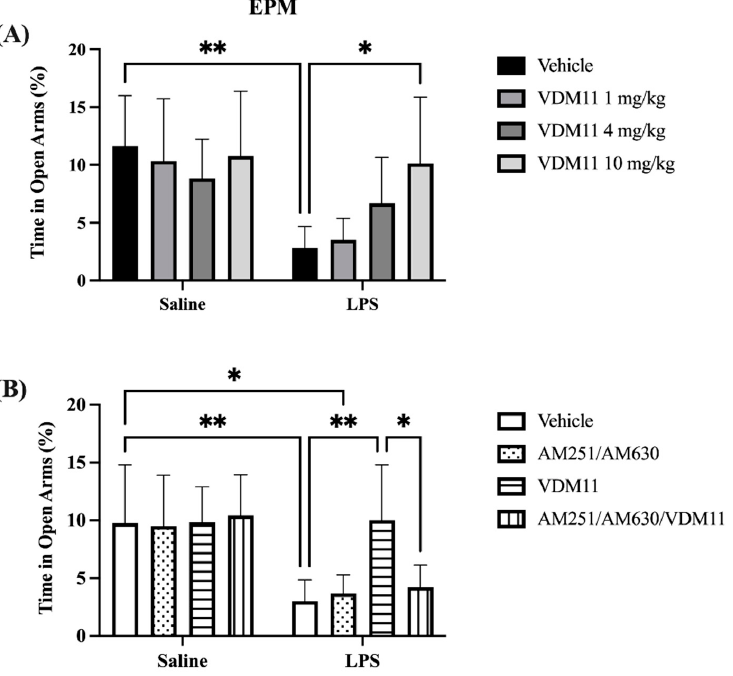
Figure 7. ( A ) VDM11 (anandamide reuptake inhibitor; 10 mg/kg) markedly enhanced exploration time in open arm (%) 25 h after LPS treatment. ( B ) Reduced effect of VDM11 on exploration time (%) due to administration of CB1 receptor antagonist AM251 and the CB2 receptor antagonist AM630. * p < 0.05; ** p <